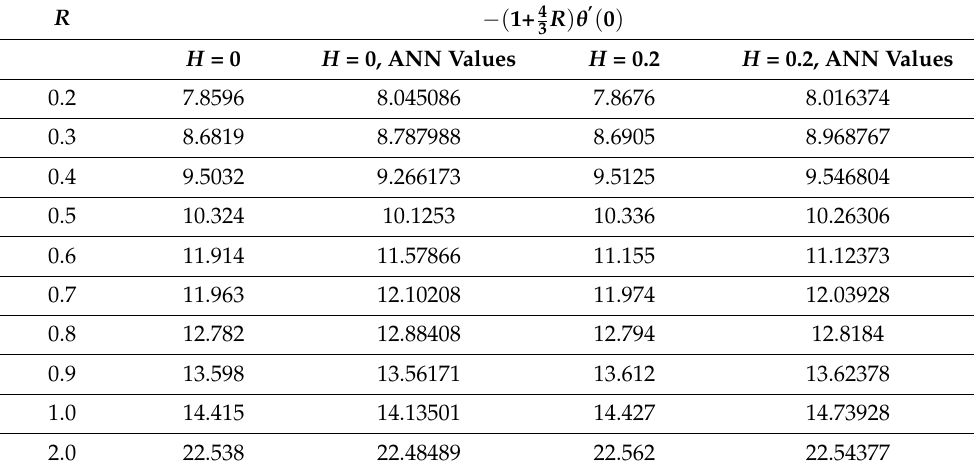
Table 4. Impact of thermal radiation parameter on Nusselt number with and without heat generation.